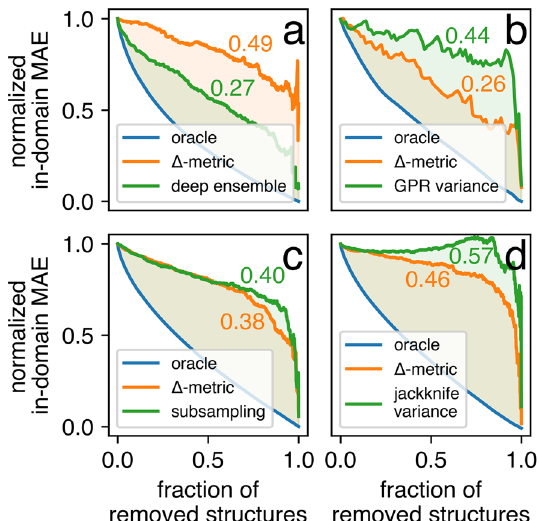
Figure 3. Confidence curves for the four considered use cases: ( a ) SNUMAT-MEGNet, ( b ) C2DB-GPR-CFID, ( c ) QMOF-KRR-ElemStat, and ( d ) OMDB-RF-PLMF. The subgraph includes three cases, the so-called oracle curve (ideal ranking according to observable error), Δ-metric curve (UQ measure presented in this study), and the curve corresponding to the competitive